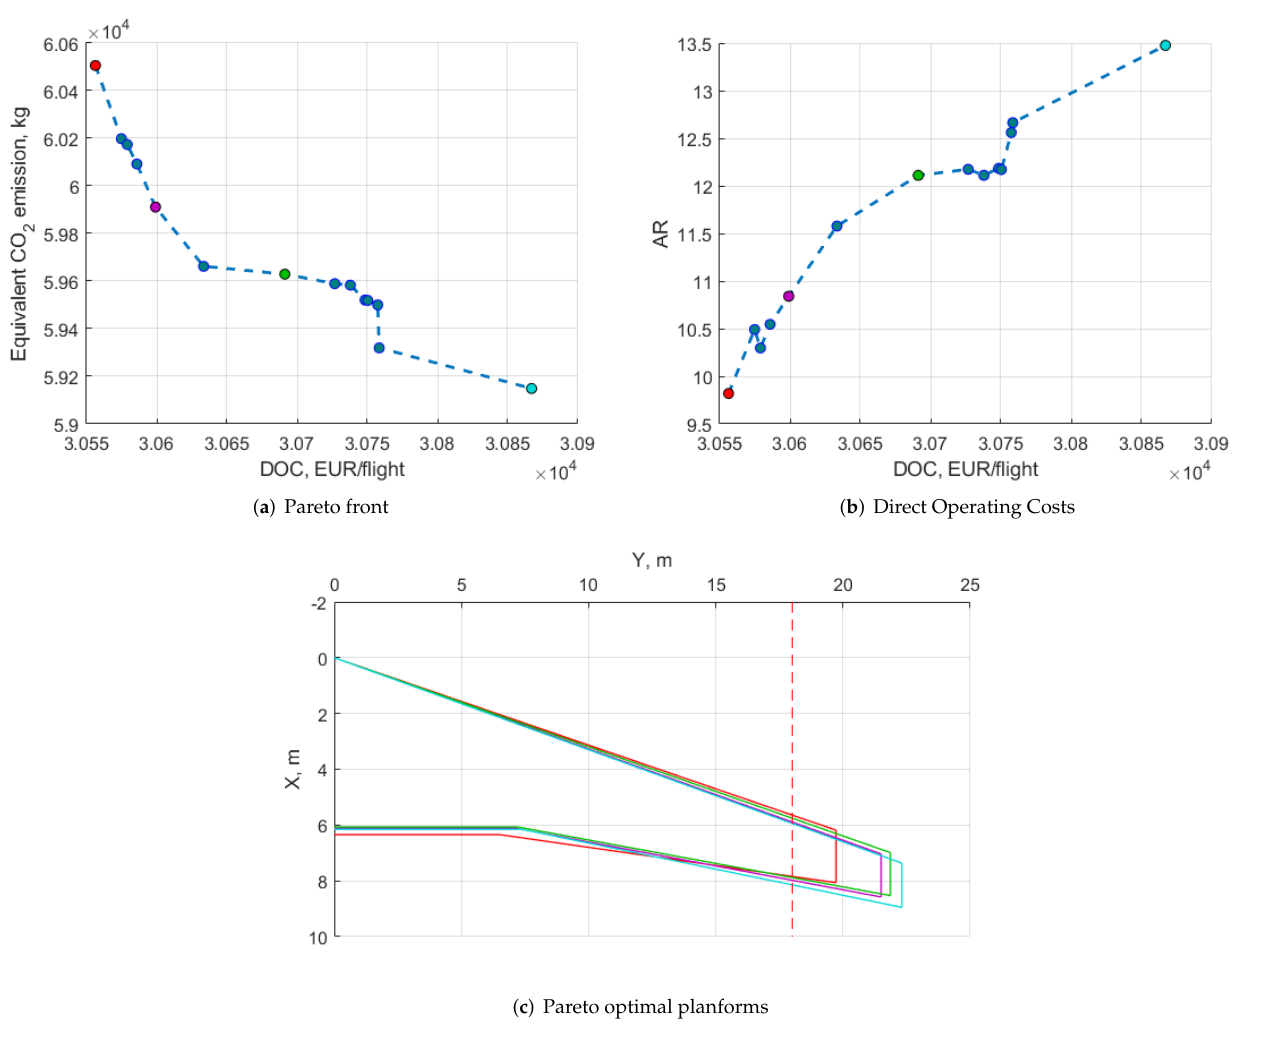
Figure A3. Optimization results for the backward-swept LFC aircraft.